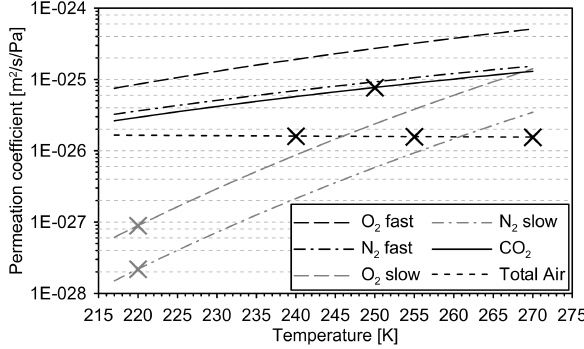
616 Fig. 2. Comparison of the different estimates of gas permeation co- efficients in ice. The black dashed line denoted with “total air” rep- resents the total air permeation value of Uchida et al. (2011). The black lines denoted with “fast” represent the “fast set” (FS) (Ikeda- Fukazawa et al., 2005) and the grey lines denoted with “slow” repre- sent the “slow set” (SS) (Salamatin et al., 2001) used for the simula- tion presented here. The CO 2 permeation coefficient is the same for both sets (Ahn et al., 2008) (solid black line). Most permeation co- efficients shown here consist of a solubility and a diffusion parame- ter. In all these cases the diffusion parameters of Ikeda-Fukazawa et al. (2004) are used whereas the solubility is adjusted accord- ingly. The crosses indicate for which ice temperature regime the corresponding parameters have an experimental support and, hence, show which parts of the parameters are extrapolated. In the case of the total air parameter the temperature regime covers a larger range as indicated by the